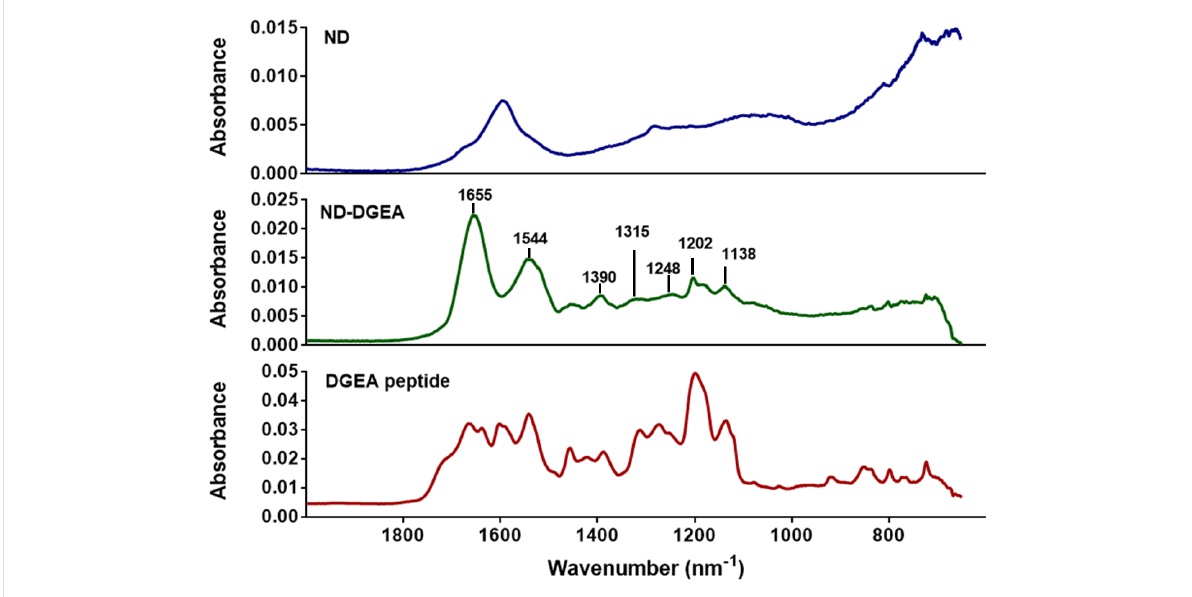
Figure 3: FTIR spectra of ND, ND-DGEA conjugates, and DGEA peptide. The presence of characteristic peaks for DGEA peptide in the spectrum for the ND-DGEA conjugates confirmed successful conjugation.